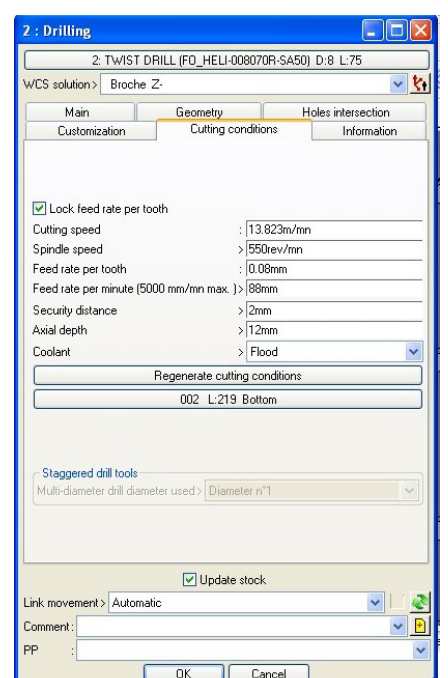
Figure 22. Wear progress for the test